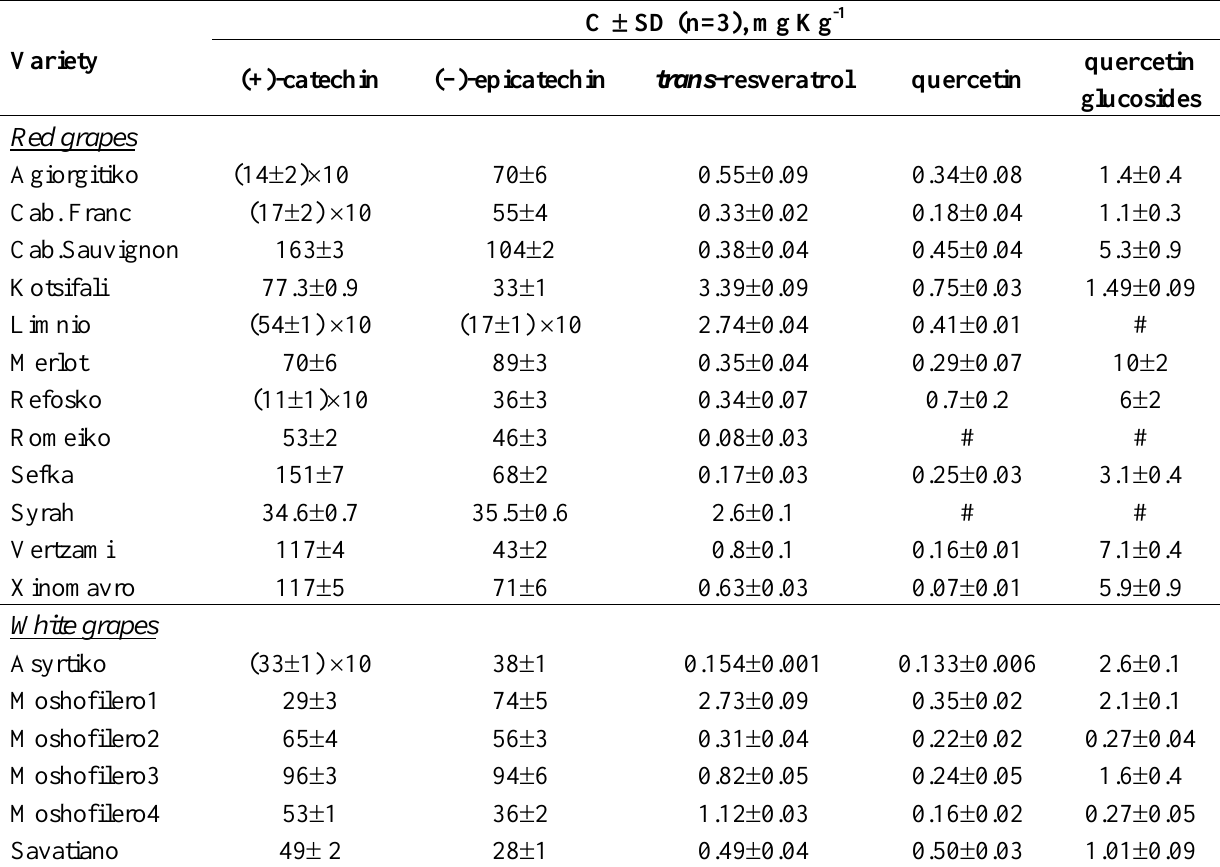
Table 4. Results of Greek grape analysis for phenolic antioxidants.